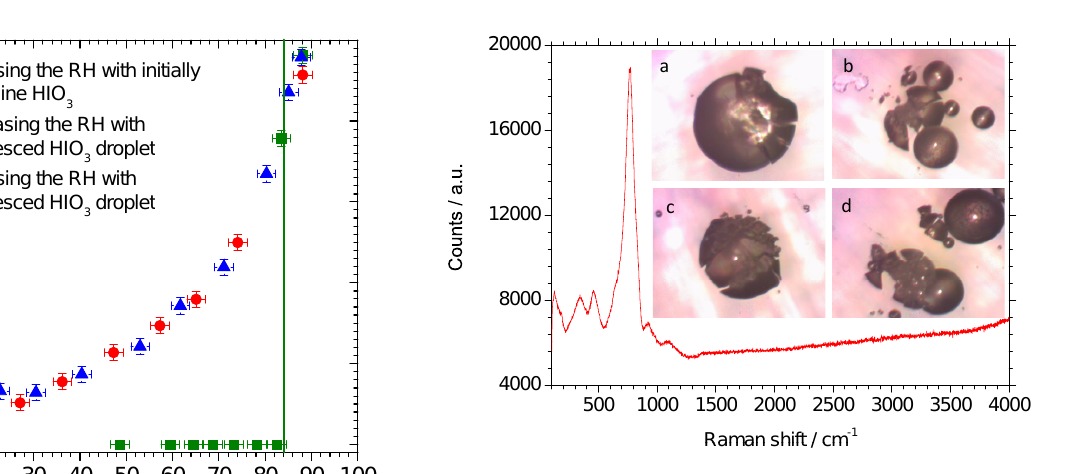
Fig. 5. Raman spectrum and images of “cracked” aqueous HIO 3 droplets at 0% RH. For this test, deliquesced droplets were dried out to 0% RH gradually over the course of ∼ 1.5 h and were then subjected to mechanical force using the flat end of a metal rod. The droplets shattered in much the same way as one would expect an ultra viscous liquid, such as pitch, or a brittle glass to shatter. The spectrum corresponds to (b). The width of the microscope images is